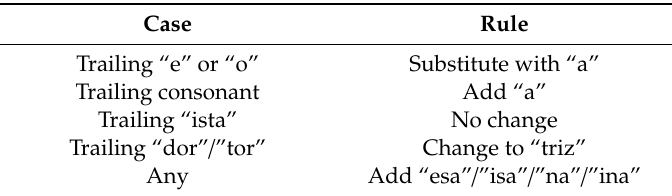
Table 4. Generating